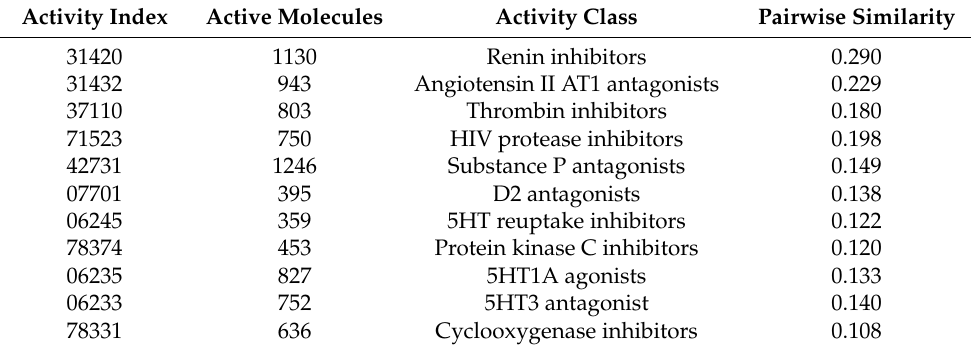
Table 1. The MDDR-DS1 structure activity classes.